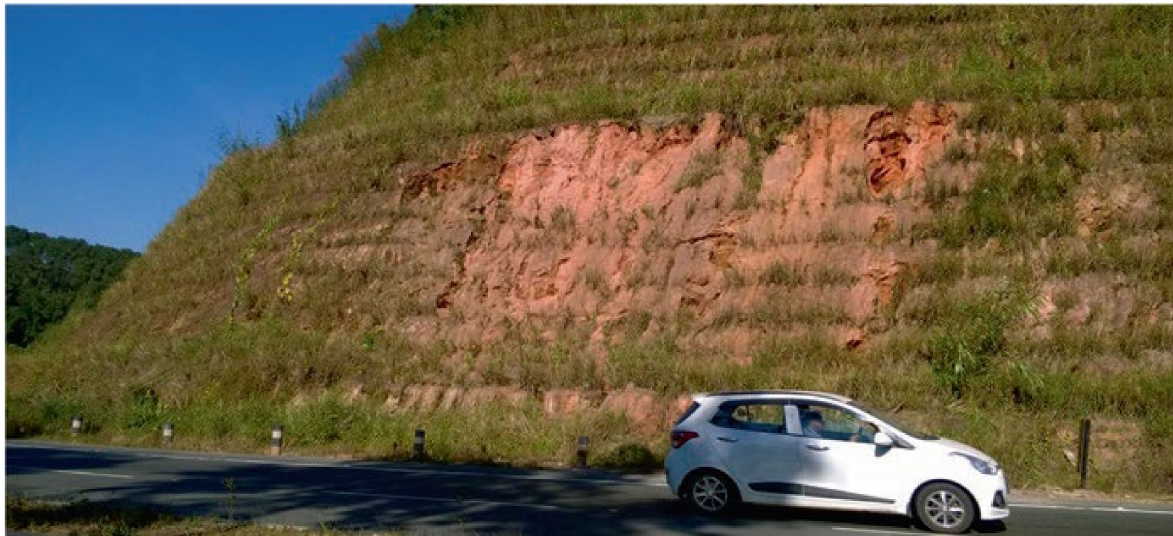
Figure 2. Vetiver grass stabilizing a cut slope along the Guwahati–Shillong National Highway, Meghalaya State, India as of July 2015